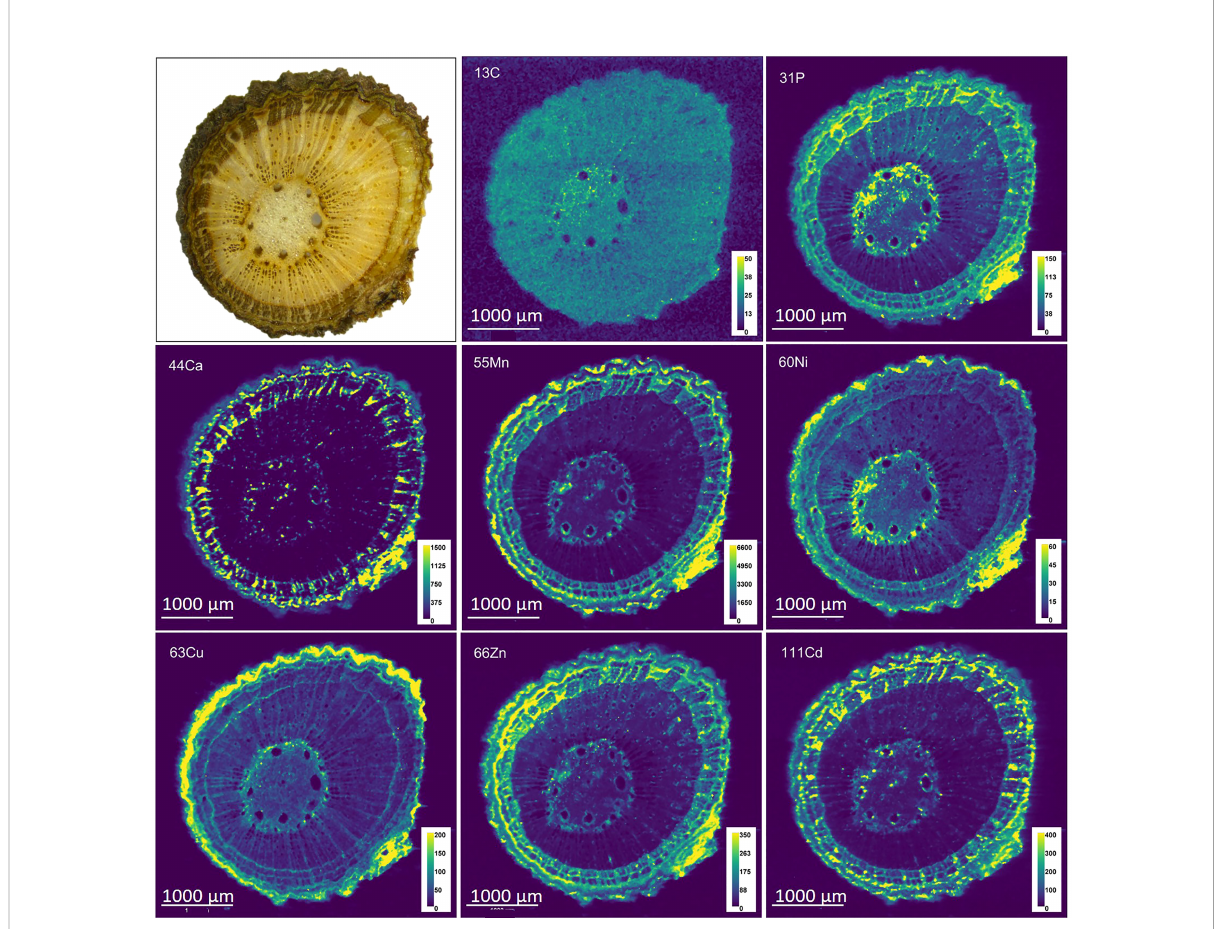
FIGURE 5 Microscope image and LA-ICP-MS elemental maps of cross section of branch T2. Cd, Ca, Mn and Zn co-localized, and less spatial correlation was found between Cd and P or Cu. The intensity is expressed in total counts (cts). The color scale is adjusted to the range of each